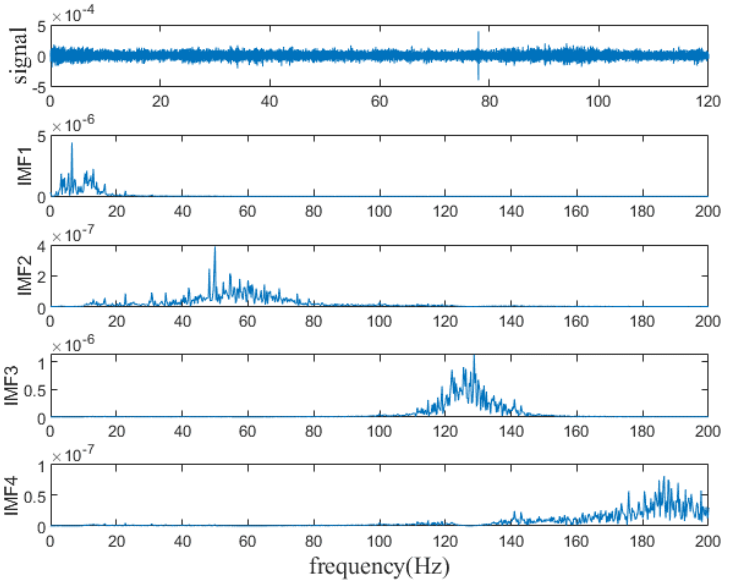
Figure 5. The spectrum of IMF components based on VMD